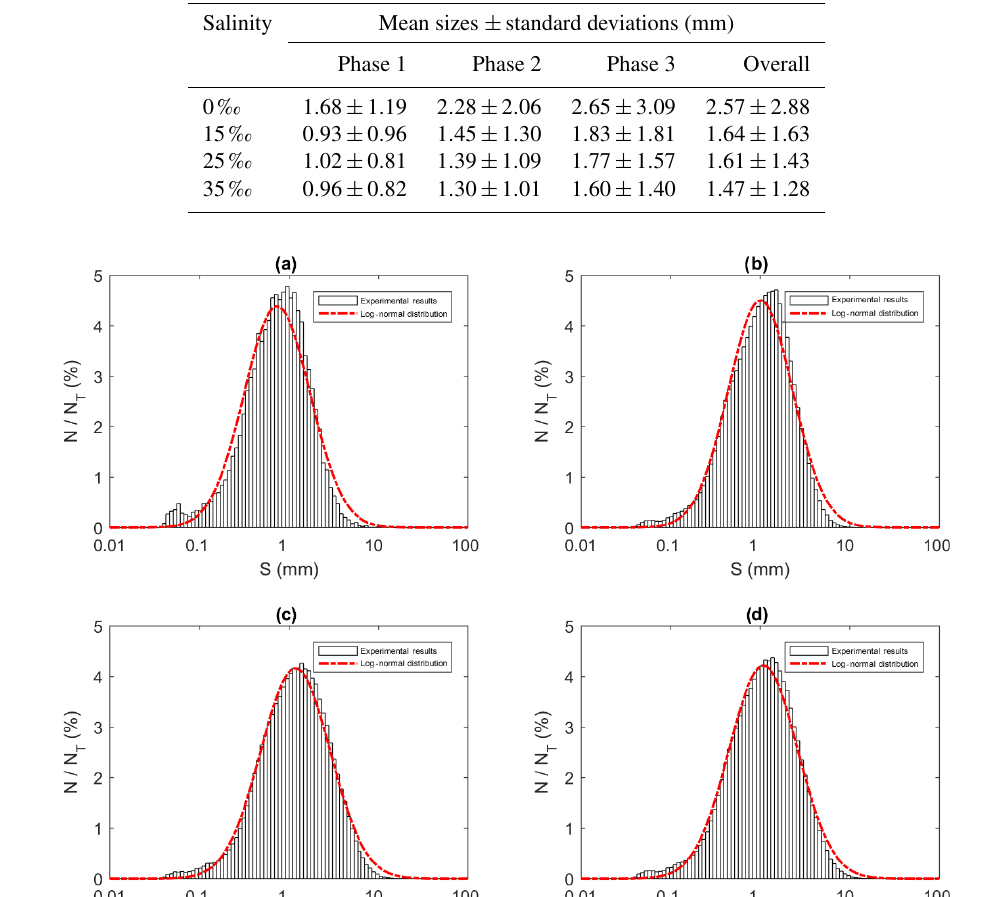
Table 4. Arithmetic mean sizes and corresponding standard deviations of frazil ice flocs during different phases at all four salinities.